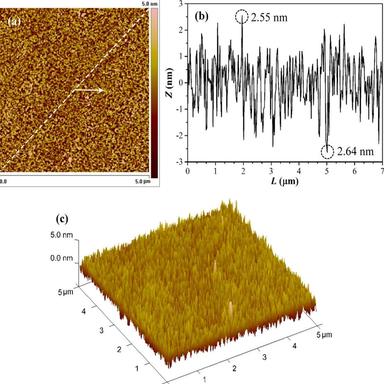
2D-AFM image (a), line scan profile (b), and 3D-AFM (c) of the initial surface.